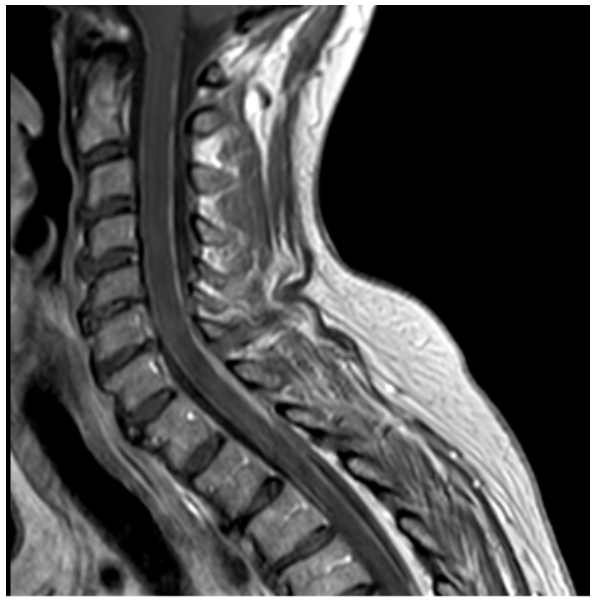
Figure 1. Cerebellar localizations of a HR-positive/HER2-negative breast cancer following CDK4/6 inhibitor palbociclib.